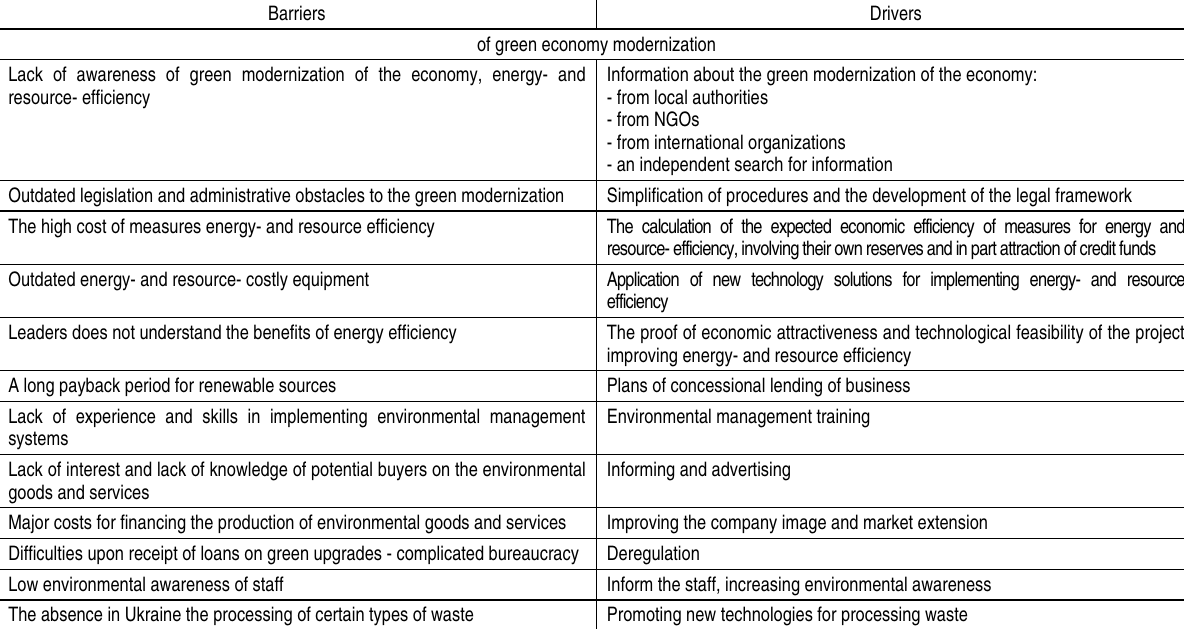
Table 2. The main barriers and drivers of development of green modernization common for Ukraine and other countries of Eastern